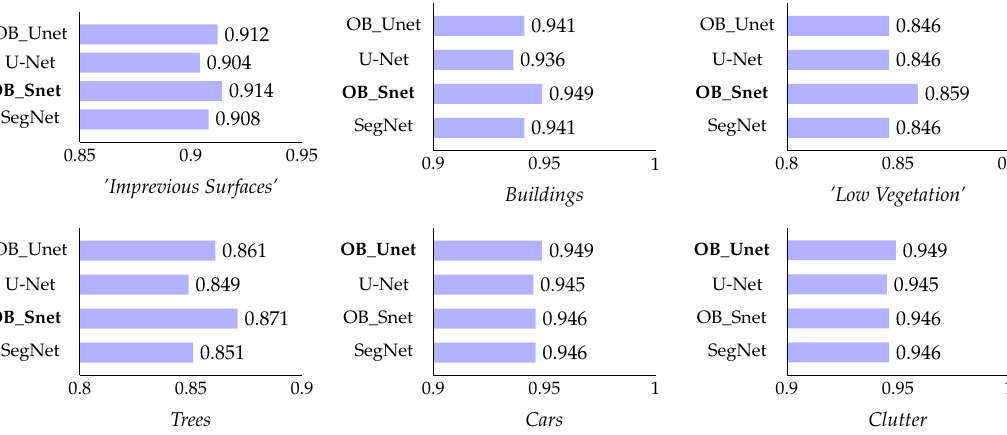
Figure 7. The resulting F1 scores from all considered methods for all semantic categories of Potsdam dataset. In all cases, the developed object-based learning framework managed to outperform the current state-of-the-art fully convolutional networks. In bold are the higher achieved F1 scores.